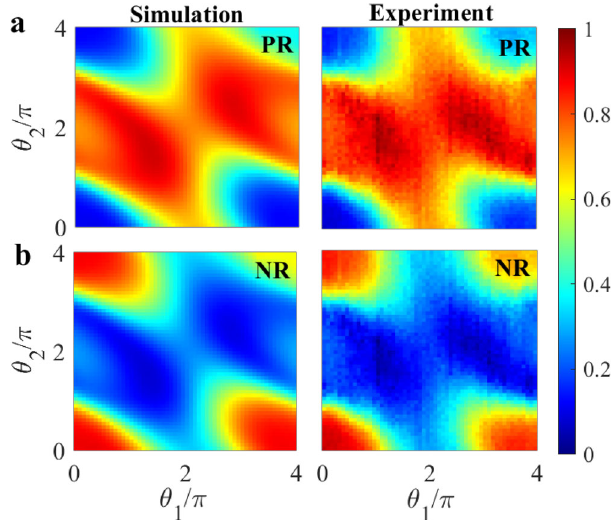
Fig. 5 | Positive and negative ratios for the N =2 case. Simulated and experi- mental 2D maps for the a Positive Ratio PR( θ 1 , θ 2 ) and for the b Negative Ratio NR( θ 1 , θ 2 ) as a function of θ 1 and θ 2